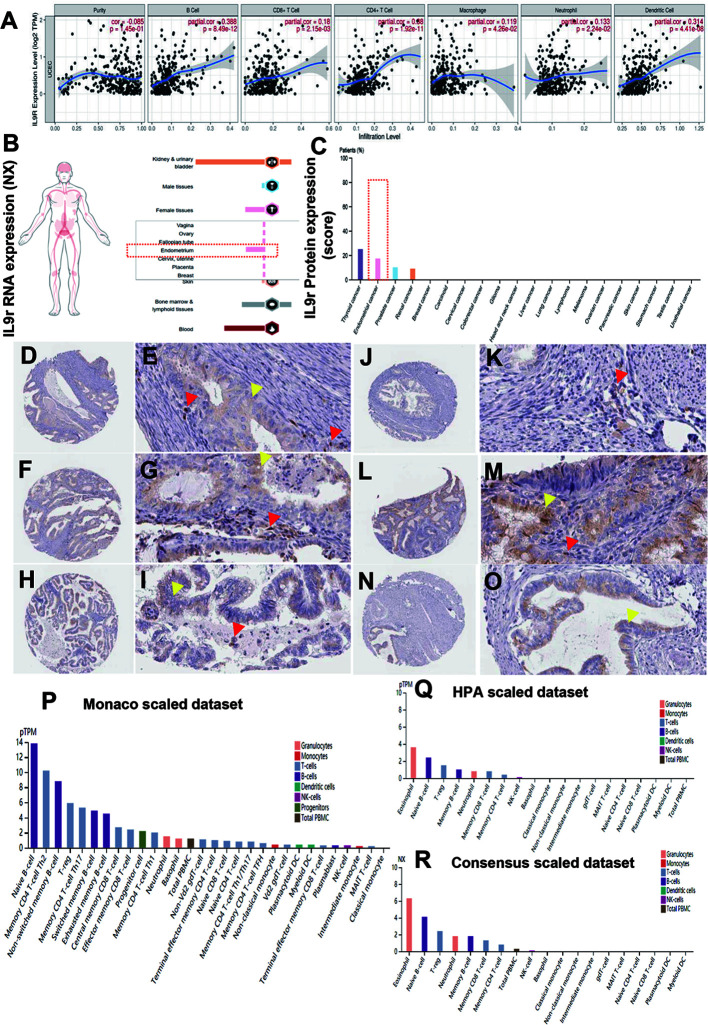
IL-9R Expression in Endometrium and EECs. (A) Correlation of IL9R expression level with immune infiltration level. (B) IL9R RNA expression was enriched in normal female tissues, especially in the endometrium; (C) IL9R protein was increased in endometrial cancer compared to renal cancer, breast cancer, and other malignancies. (D–M) In most of the endometrial cancers, IL9R was detected in tumor cells and infiltrated lymphocytes. (N, O) In a few cases, IL9R was only expressed in tumor cells. (P–R) IL9R RNA expression in immune cells was analyzed in Monaco and HPA datasets and found that IL9R was up-regulated in Naïve-B cells, TH2 cells, Tregs, eosinophils, and neutrophils.